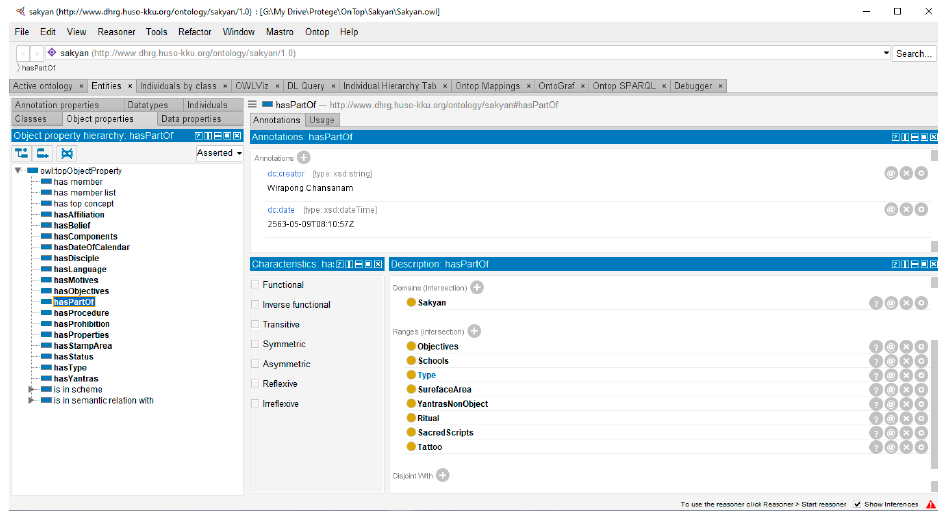
Figure 3. Object properties of Sak Yan ontology.